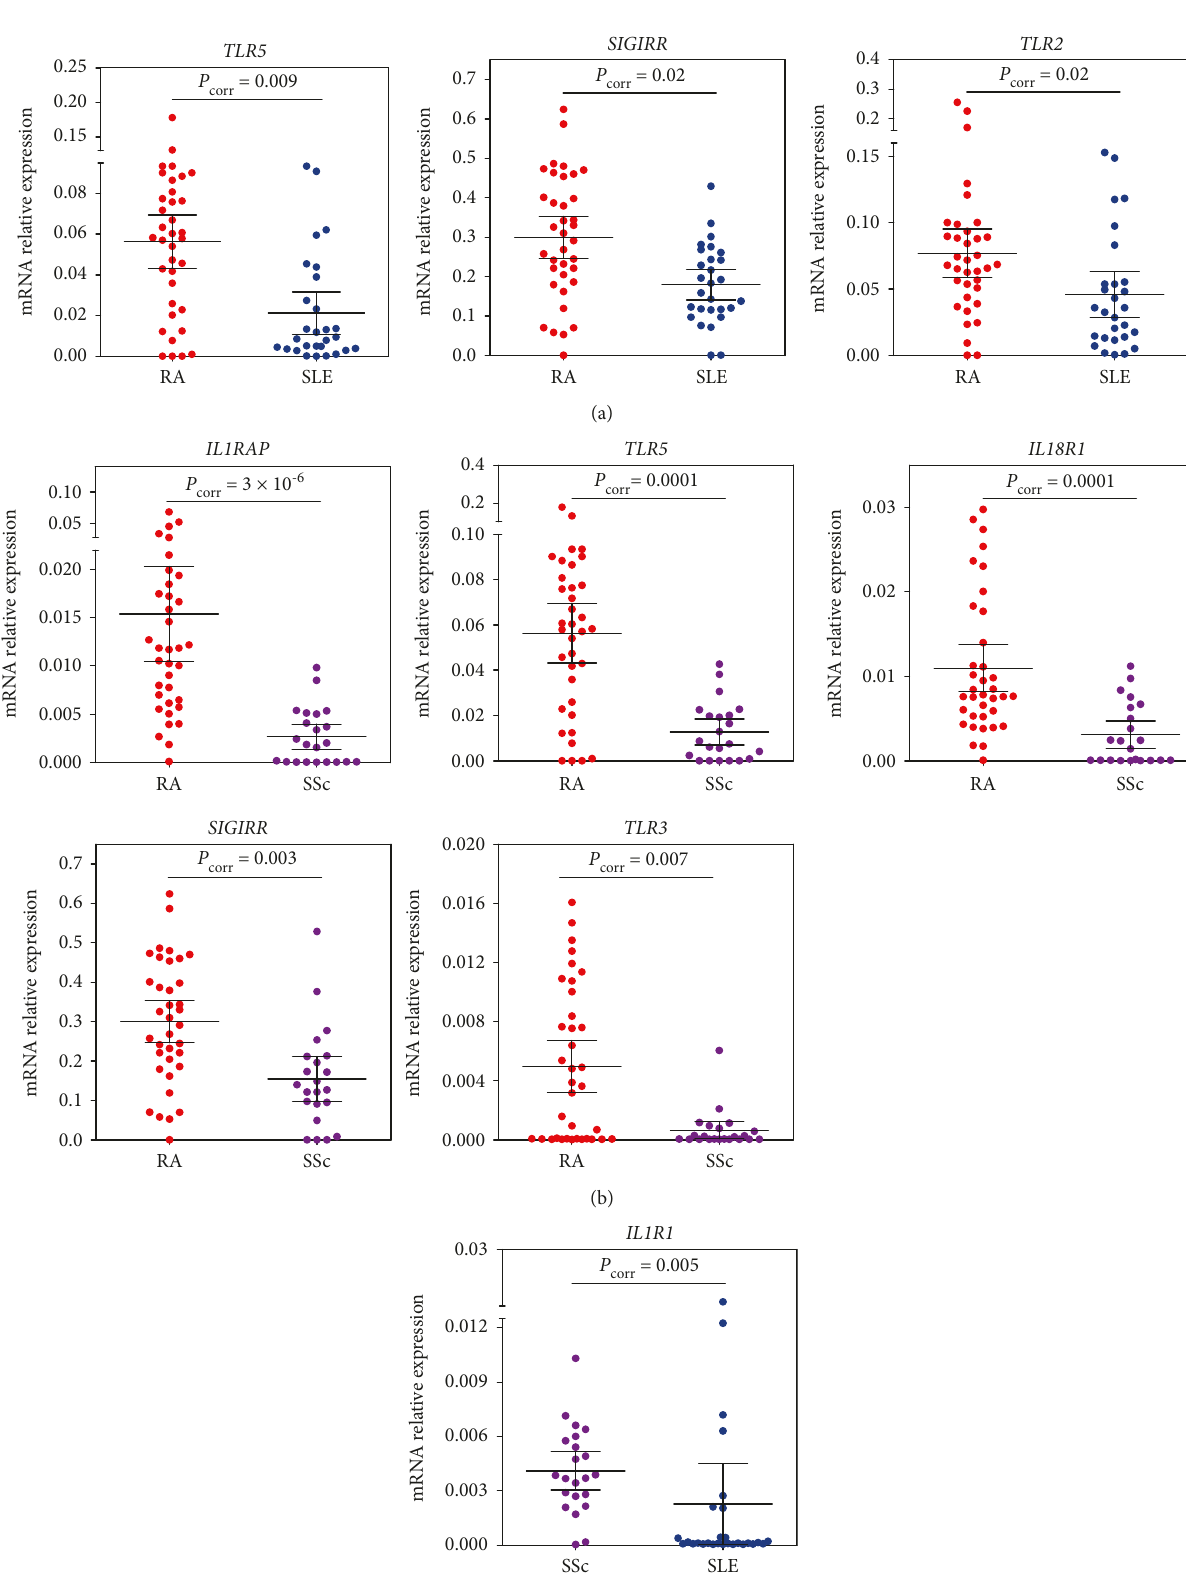
Figure 1: Relative mRNA expression levels of genes di ff erentially expressed in (a) RA vs. SLE, (b) RA vs. SSc, and (c) SSc vs. SLE. Group means are indicated by horizontal bars; error bars indicate 95%